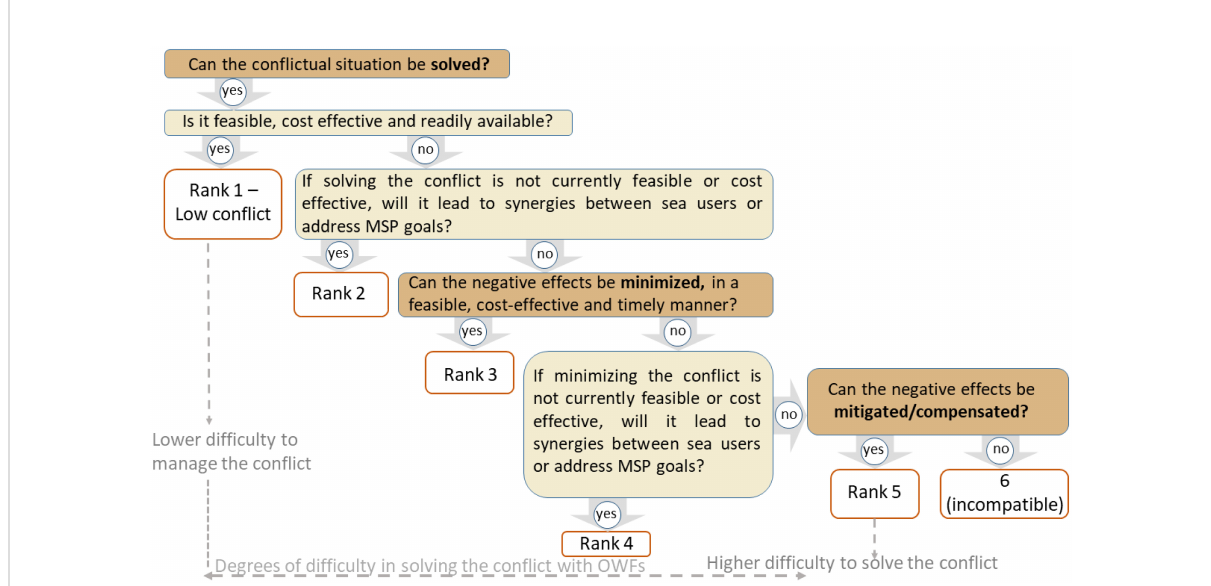
FIGURE 3 Spatial distribution (cumulated area of con fl ict) of con fl icts (ACS) within the OWF valuable sites, for military activities sea user group types –